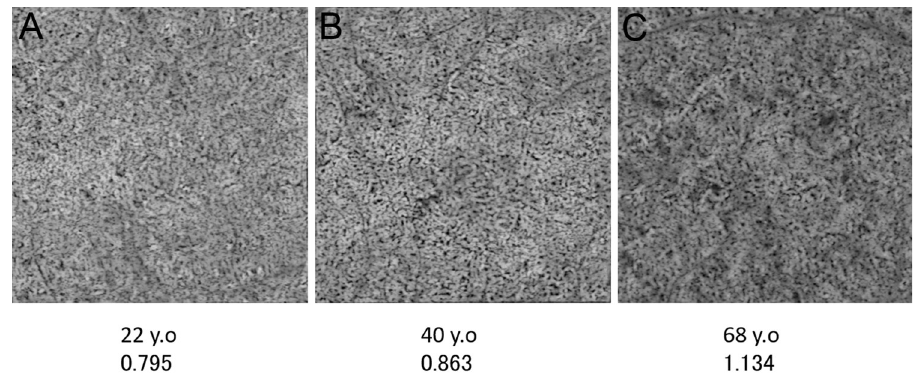
Fig 4. Representative en face OCTA images of the choriocapillaris in each age group. A. Image from a 22-year-old woman; the total area, size, and number of flow voids are 0.80 mm 2 , 415 μ m 2 , and 1921, respectively. The VDI is 7.25. B. Image from a 40-year-old man; the total area, size, and number of flow voids are 0.86 mm 2 , 457 μ m 2 , and 1899, respectively. The VDI is 7.04. C. Image from a 68-year-old man; the total area, size, and number of flow voids are 1.13 mm 2 , 727 μ m 2 , and 1569, respectively. The VDI is 7.21.